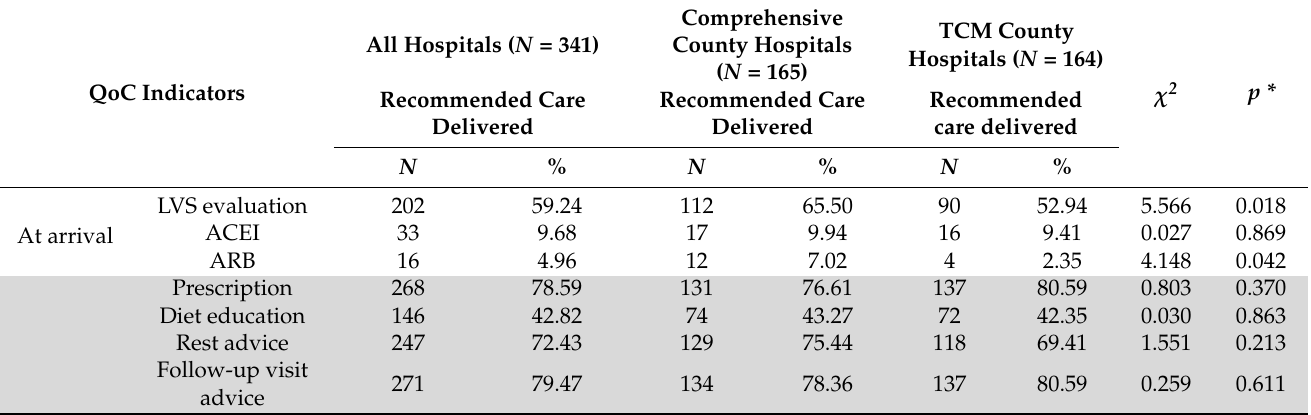
Table 9. Level of QoC for heart failure in 2 kinds of county hospitals ( N =